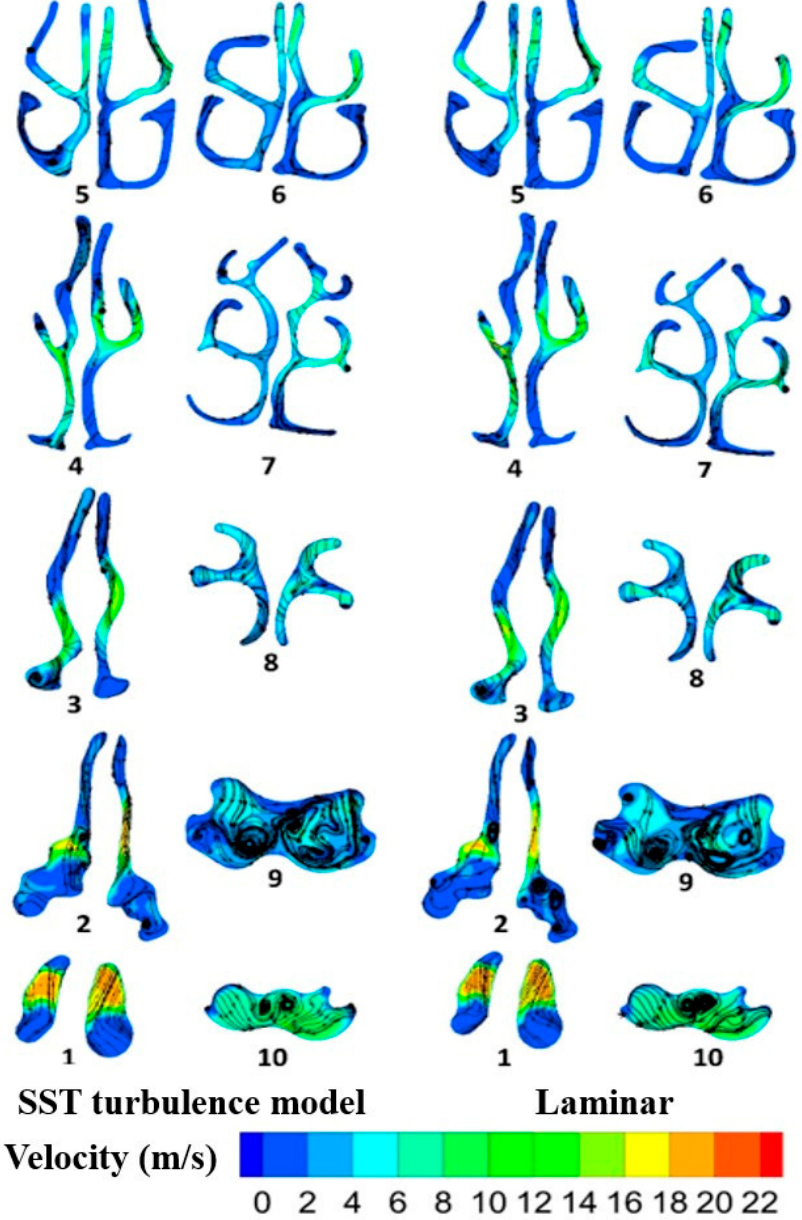
Figure 6. Velocity magnitude with streamlines at the cross-sections between vestibule and nasopharynx for the laminar and SST models. A wide range of cross sections are considered from nostril to nasopharynx (1 to 10) to depict the flow pattern in entire nasal airway.